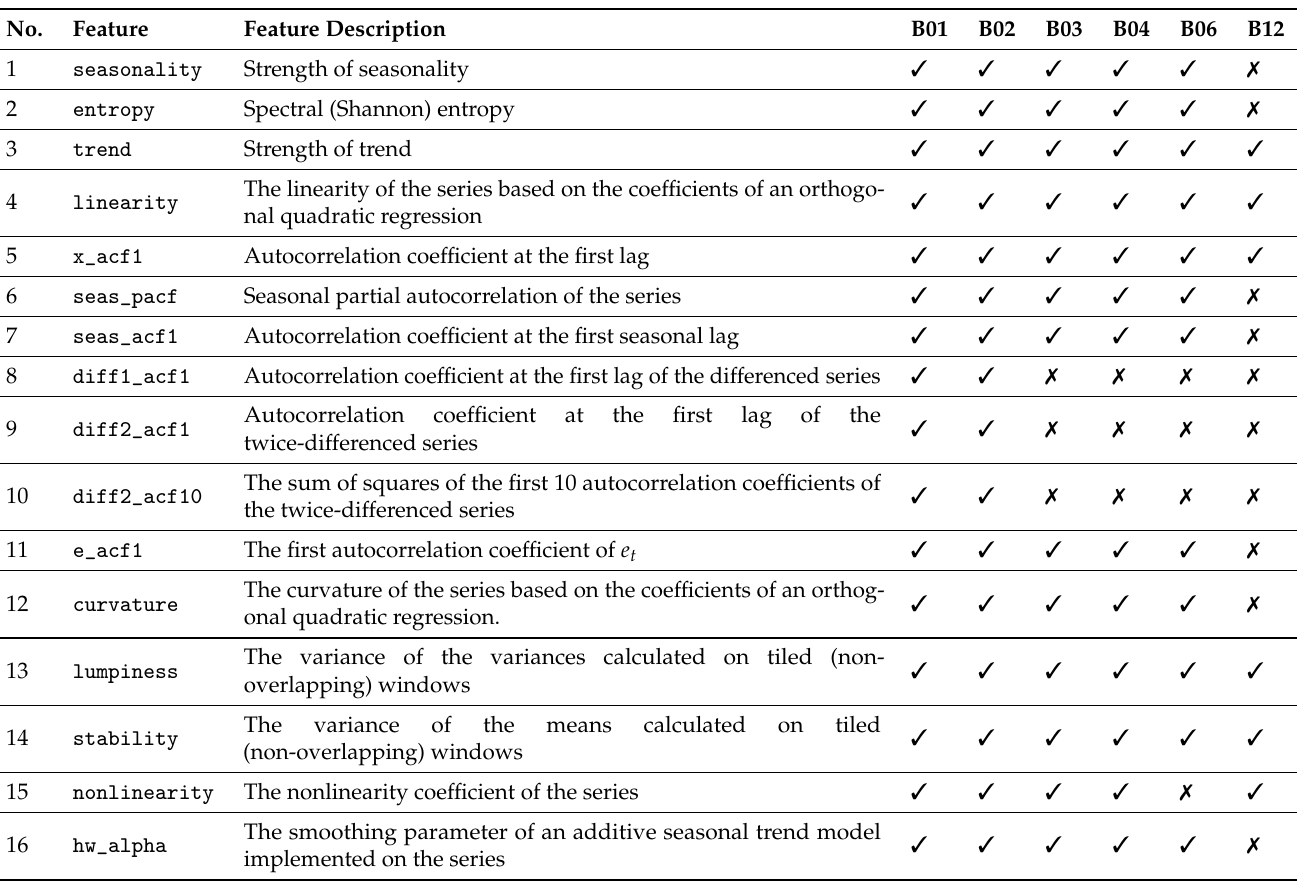
Table A2. Features used for the fast-moving series (M4 competition data